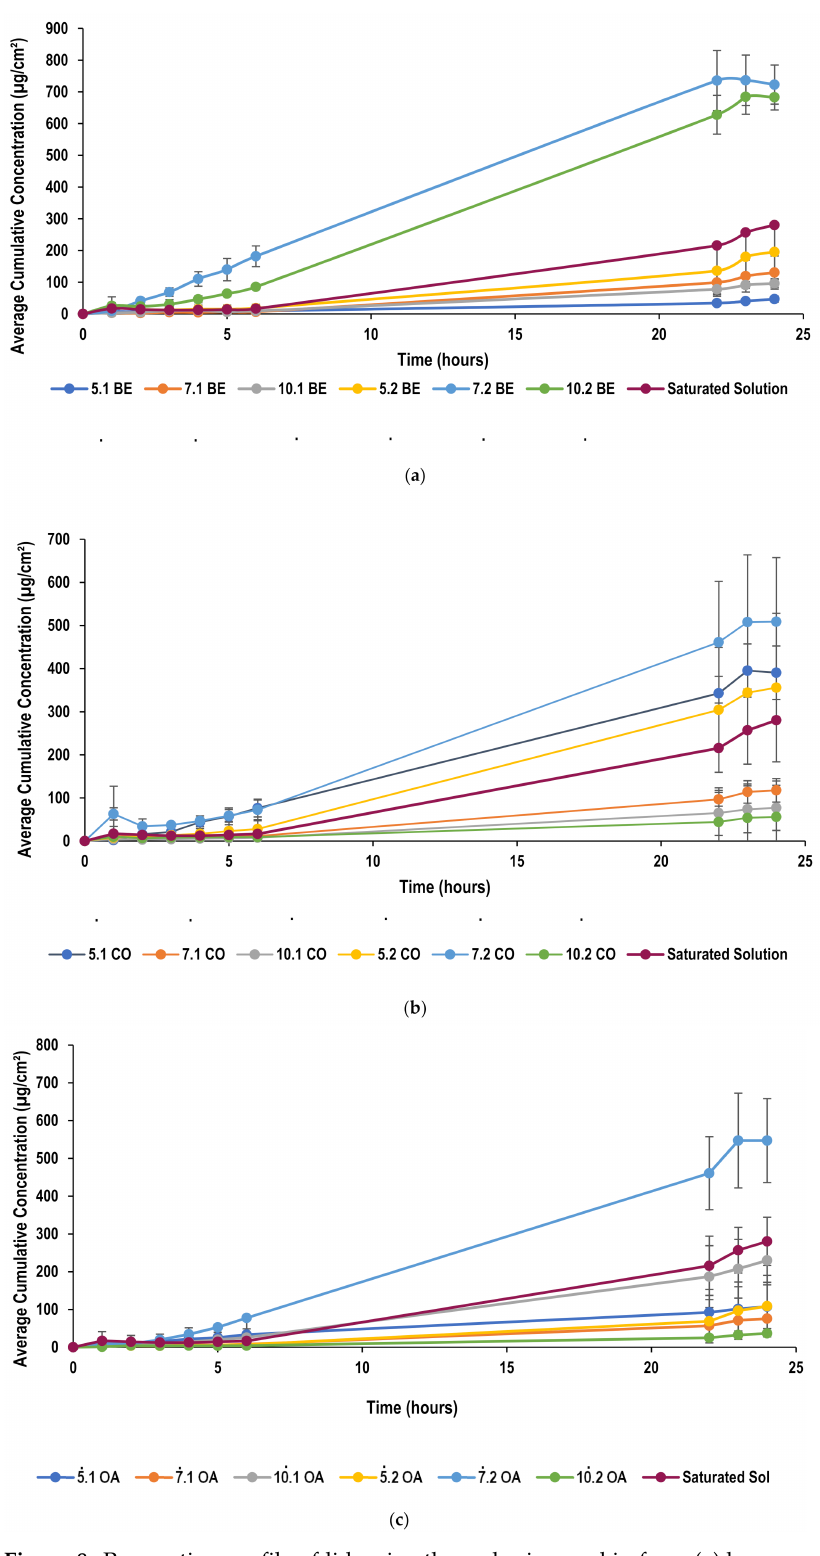
Figure 8. Permeation profile of lidocaine through pig ear skin from ( a ) beeswax formulations ( b ) coconut oil formulations and ( c ) oleic acid